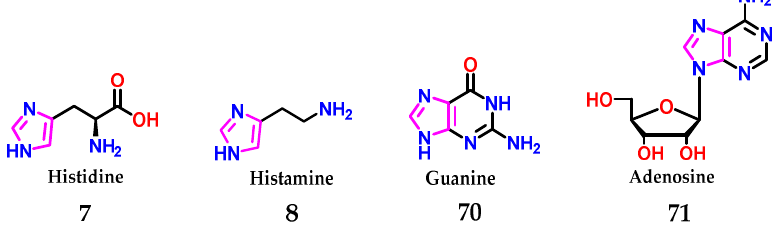
Figure 27. Presence of the imidazole 1 nucleus in several biologically active compounds.